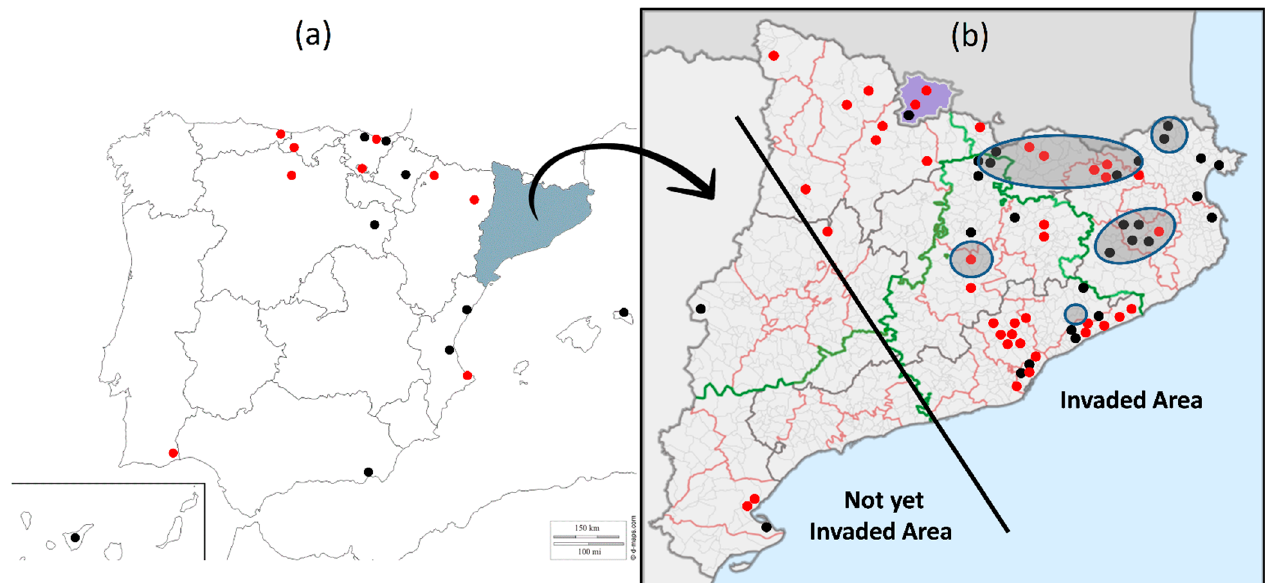
Figure 1. Localities of ( a ) the Iberian Peninsula and Canary and Balearic islands (except Catalonia) and ( b ) Catalonia and Andorra (in purple) where H. axyridis was recorded in spring or summer. Black and red points correspond to records before and after 2015, respectively. Grey ovals indicate the areas were overwintering aggregations have been found. The straight black line separates the updated hypothetical invaded area from the not yet invaded area within Catalonia.